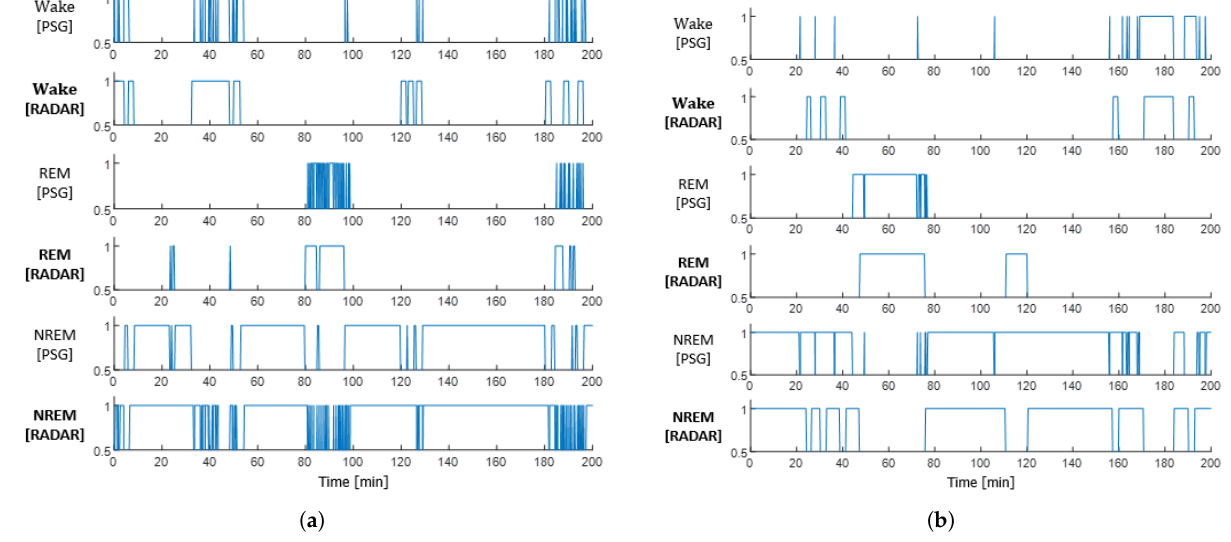
Figure 7. Three-stage sleep-detection results using FMCW radar. ( a ) Subject 1. ( b ) Subject